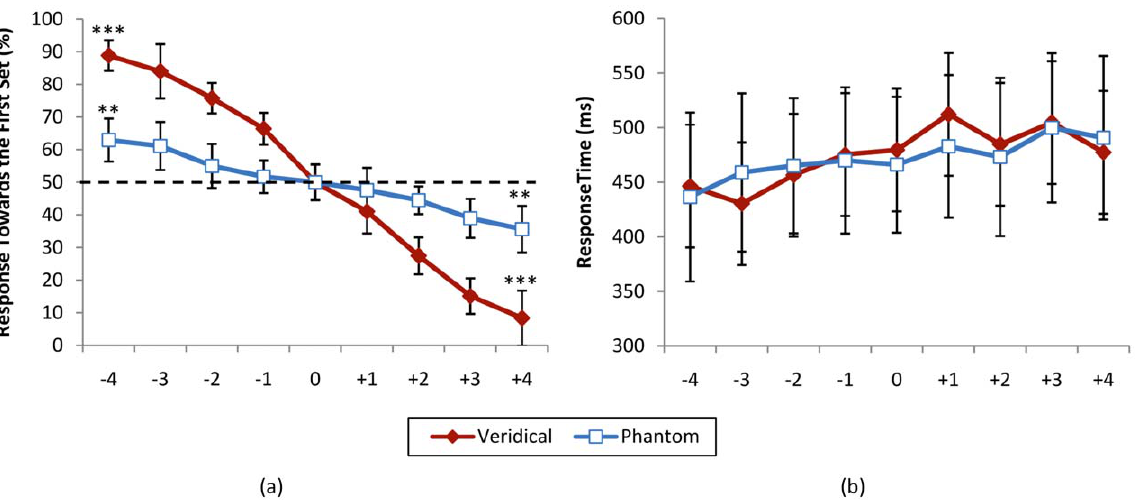
Figure 3. Psychometric function for the numerosity judgement task. (a) Percentage response towards the first set and (b) response time for veridical ( n 1 ? n 2 , t 1 = t 2 ) and phantom ( n 1 = n 2 , t 1 ? t 2 ) conditions. Horizontal axis shows different levels of comparison ( n 2 2 n 1 for veridical and t 2 2 t 1 for phantom trials). *** p , 0.001, ** p , 0.005. Error bars reflect one standard deviation.